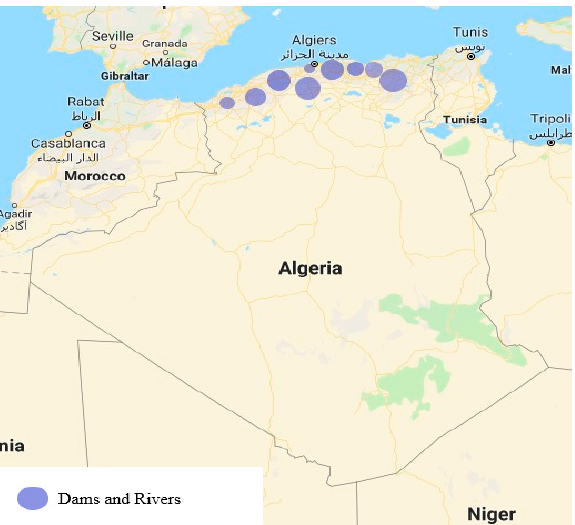
Figure 10. Potential dam and river locations in Algeria for hydropower generation.